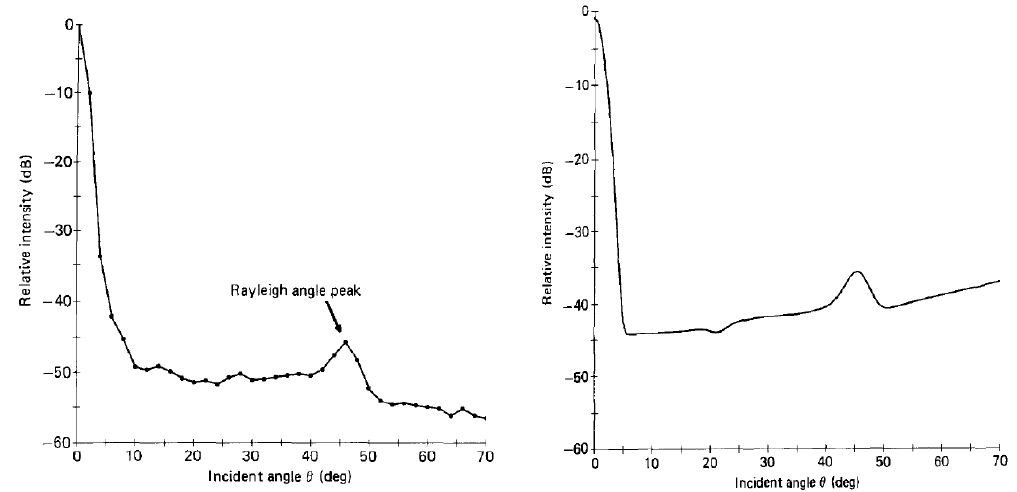
Figure 4. Blakemore’s Figures 2 and 11 [36]. Experimental validation of Blakemore’s perturbation theory at first order: at left measurements from de Billy et al. [37] on a brass plate immersed in water; at right, Blakemore’s results with frequency = 2.2 MHz, angular beam width = 3 ◦ , observation distance = 300 mm, RMS surface height σ = 14.9 µ m and the correlation lengths L x = 90 µ m and L y = 105 µ m. Reproduced with permission from [36], Elsevier, 1993.